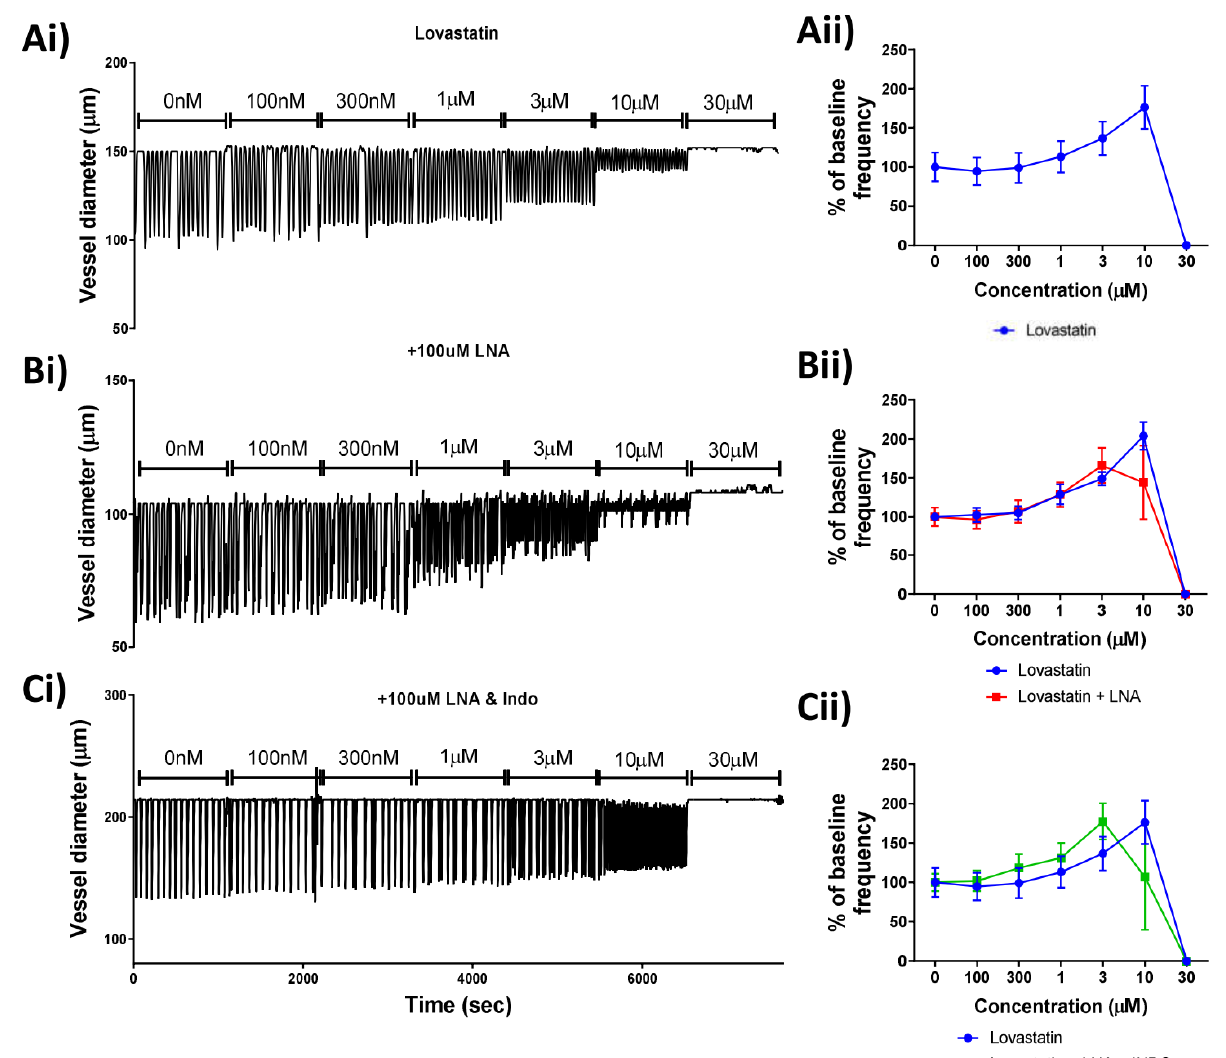
Figure 4. Effect of Lovastatin on the contractibility of mesenteric collecting lymphatic vessels is independent of nitric oxide and/or prostaglandin synthesis. Representative traces of isolated and pressurized rat mesenteric lymphatic vessels were incubated with increasing concentrations of ( Ai ) Lovastatin, ( Bi ) LNA pre-treated vessels, or ( Ci ) vessels pre-treated with LNA + Indomethacin. ( Aii – Cii ) Plots for vessel contraction frequency displayed as a percentage of baseline, monitored for a 5 min period at each incremental concentration of Lovastatin. Raw representative traces are shown, clipped to 5 min periods. Data are presented as the percentage of baseline frequency of individual vessels. n = 5–10 individual experiments.